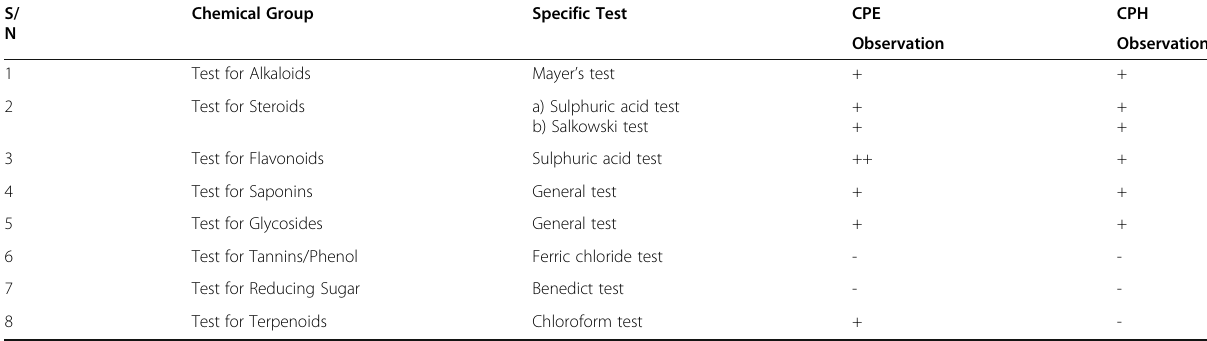
Table 2 Qualitative phytochemical screening of crude ethanol and hot water extract of Cassava peel biogas slurry